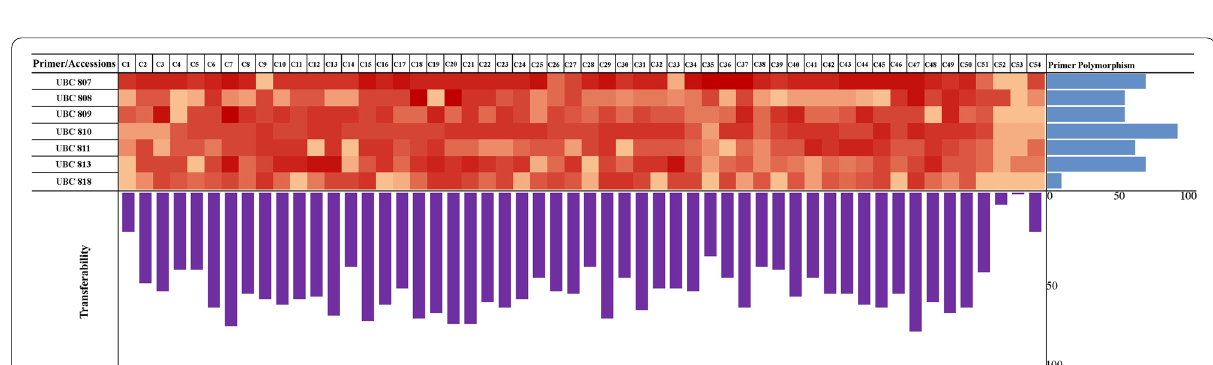
Fig. 2 Details of the cross-amplification or cross-transferability and marker polymorphism among the 54 different Capsicum species. Light and dark colour boxes represent high and low level of DNA banding in the respected chilli accessions under marker or primer amplification. The bars represent the percentage of marker polymorphism and